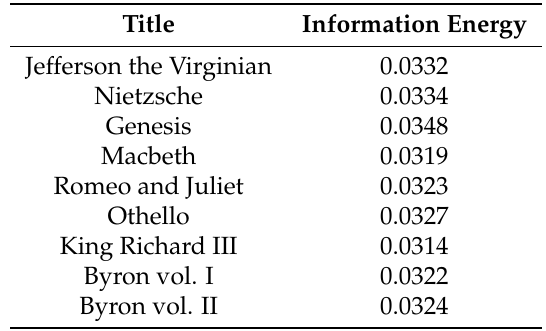
Table 4. Informational energy of English writings.